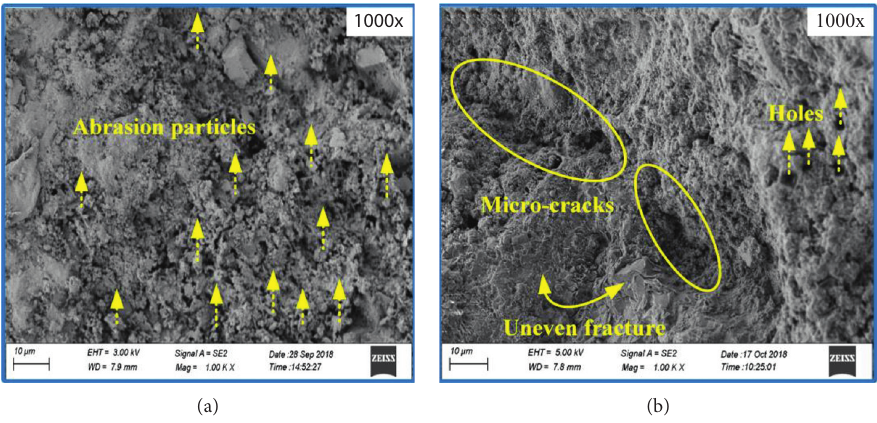
Figure 8: Typical SEM images of the mortar matrix sections. (a) AWJ impact; (b) PWJ